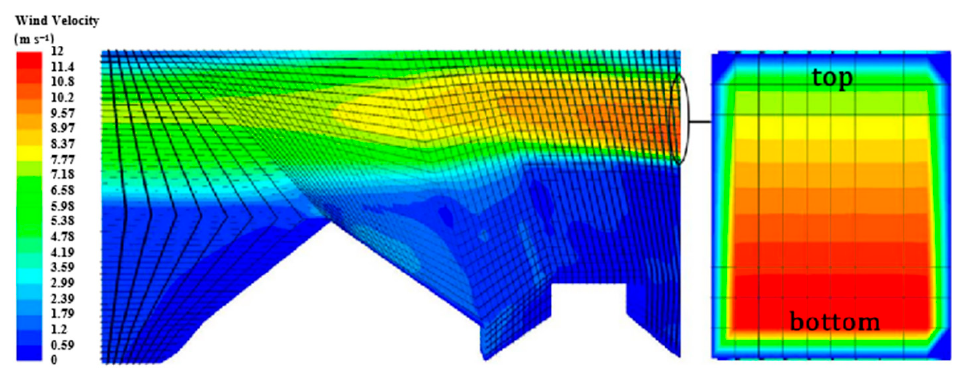
Figure 5. Structure of wind field.